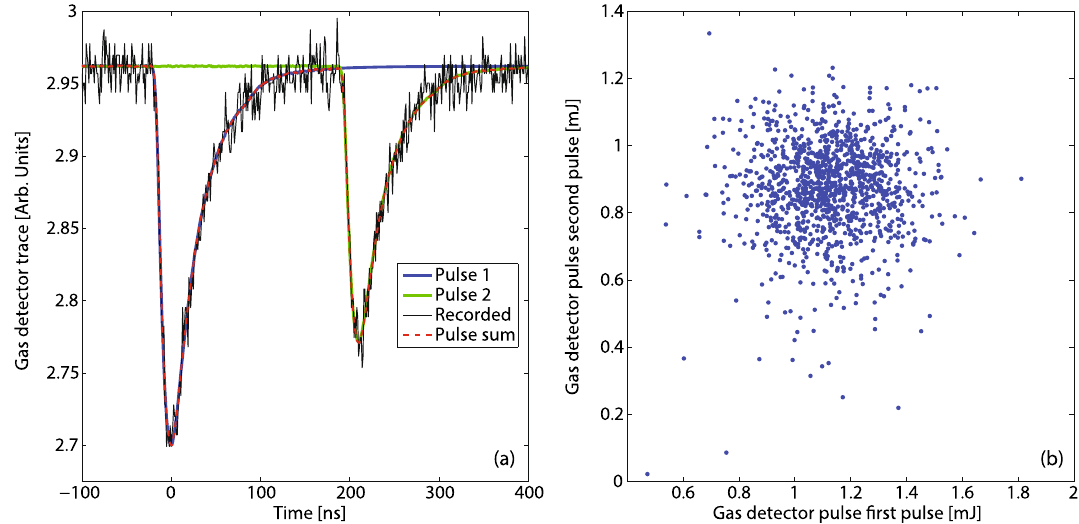
Figure 7. ( a ) Single-shot gas monitor detector traces for a two-bucket configuration with 210 ns delay (CBXFEL-like case). The recorded signal (black) is decomposed in the sum (dashed red) of two contributions, the first pulse (blue) and the trailing pulse (green). The first pulse energy was measured to be 1.25 mJ, and the second pulse energy was measured to be 0.91 mJ. ( b ) Intensity of the first pulse versus intensity of the second pulse on 1200 consecutive